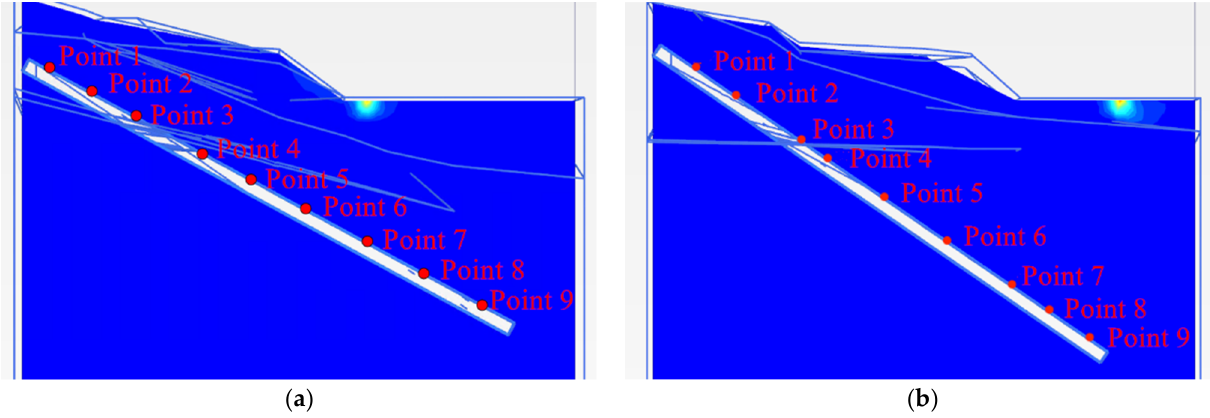
Figure 8. Schematic layout of measurement points. ( a ) East exhaust inclined shaft measurement point; ( b ) east sand injection inclined shaft measurement point.